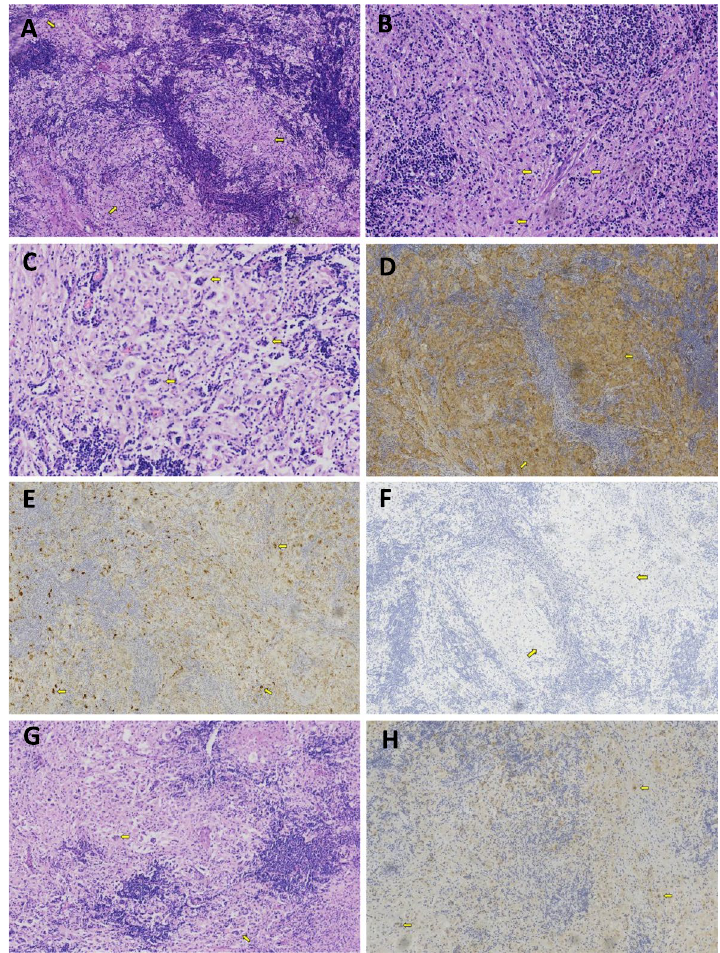
Fig. 2 Histopathology and immunohistochemistry. A Histiocyte proliferation with lymphocyte and plasma cell infiltration in the background (HE staining, 100X). B Histiocytes are rich in cytoplasm, slightly eosinophilic, with round or oval nuclei (HE staining, 400X). C Lymphocytes and plasma cells engulfed within histiocytes. D Histiocytes are positive for S-100 with immunohistochemical staining. E Histiocytes are positive for KP-1 with immunohistochemical staining. F Histiocytes are negative for CD1a with immunohistochemical staining. Histopathological findings ( G ) and histiocytes positive for S-100 with immunohistochemical staining ( H ) confirmed the